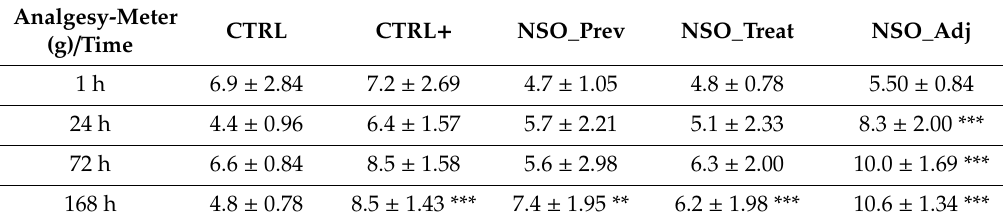
Table 7. Analgesic e ff ect of NSO on sub-acute